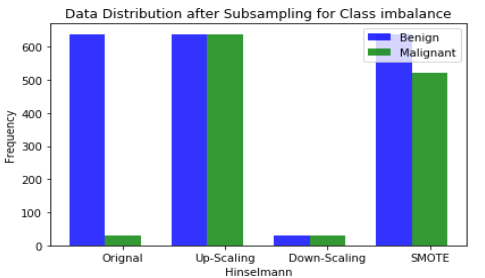
Figure 2 . Balanced dataset for target variable Hinselmann